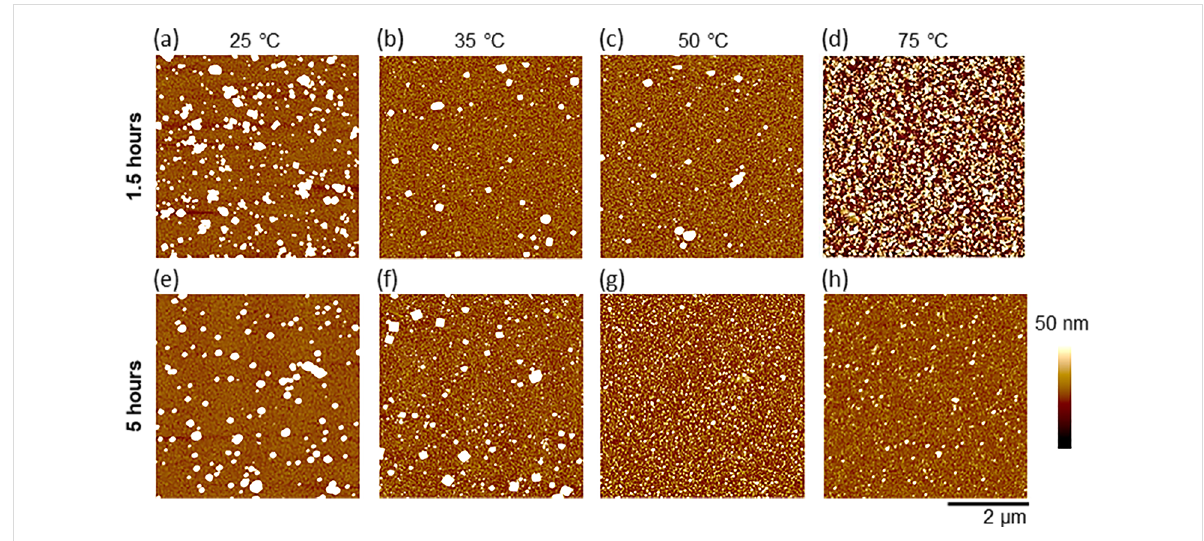
Figure 2: Representative AFM images (5 μ m × 5 μ m) of HKUST-1 surMOFs fabricated via codeposition at different temperatures (as indicated above each column of images) on SAM-coated Au surfaces. Samples were exposed for different durations; either 1.5 h (a–d) or 5 h (e–h). All images were set to the same z -scale (50 nm) for visual